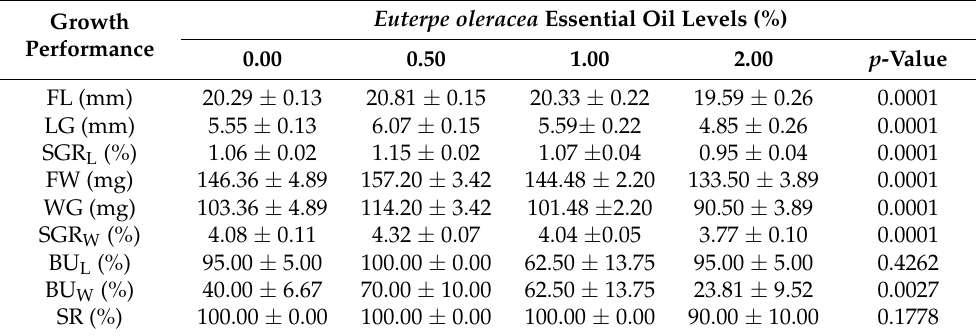
Table 3. Growth performance (mean ± standard deviation) of H. severus post-larvae fed diets containing levels of Euterpe oleracea essential